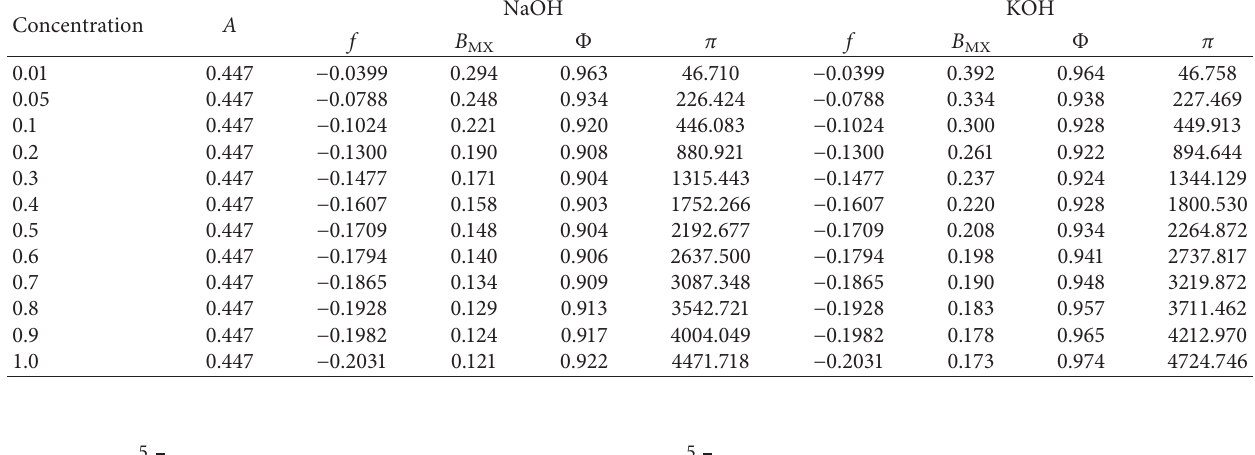
Table 2: Calculation results of osmotic suction in alkali solution.